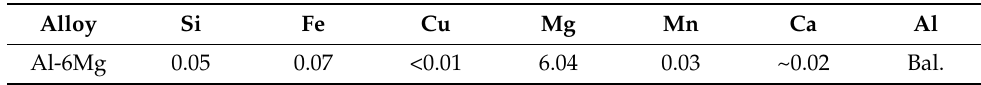
Table 1. Chemical composition of Al-6Mg alloy (wt.%, measured by ICP-AES). Alloy